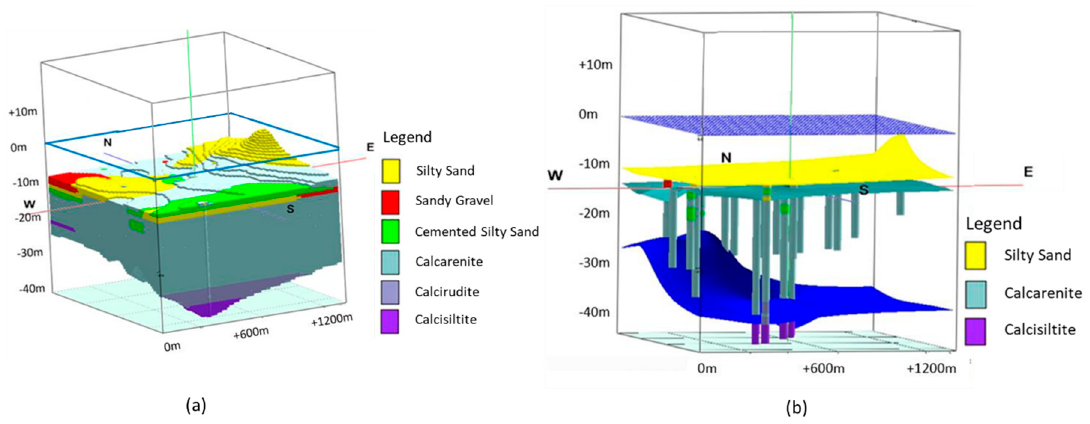
Figure 6. 3D Geological models of the pre-reclamation site area. ( a ) shows a 3D solid model of all the units encountered in the analyzed boreholes. ( b ) shows the top surface interpolated for the geological units that have been encountered three or more times in the analyzed boreholes; if the unit is encountered less than three times, this has not been shown in the interpolation results. In both images, the upper blue line and surface indicate the seawater level in m Dubai Municipality Datum (DMD).